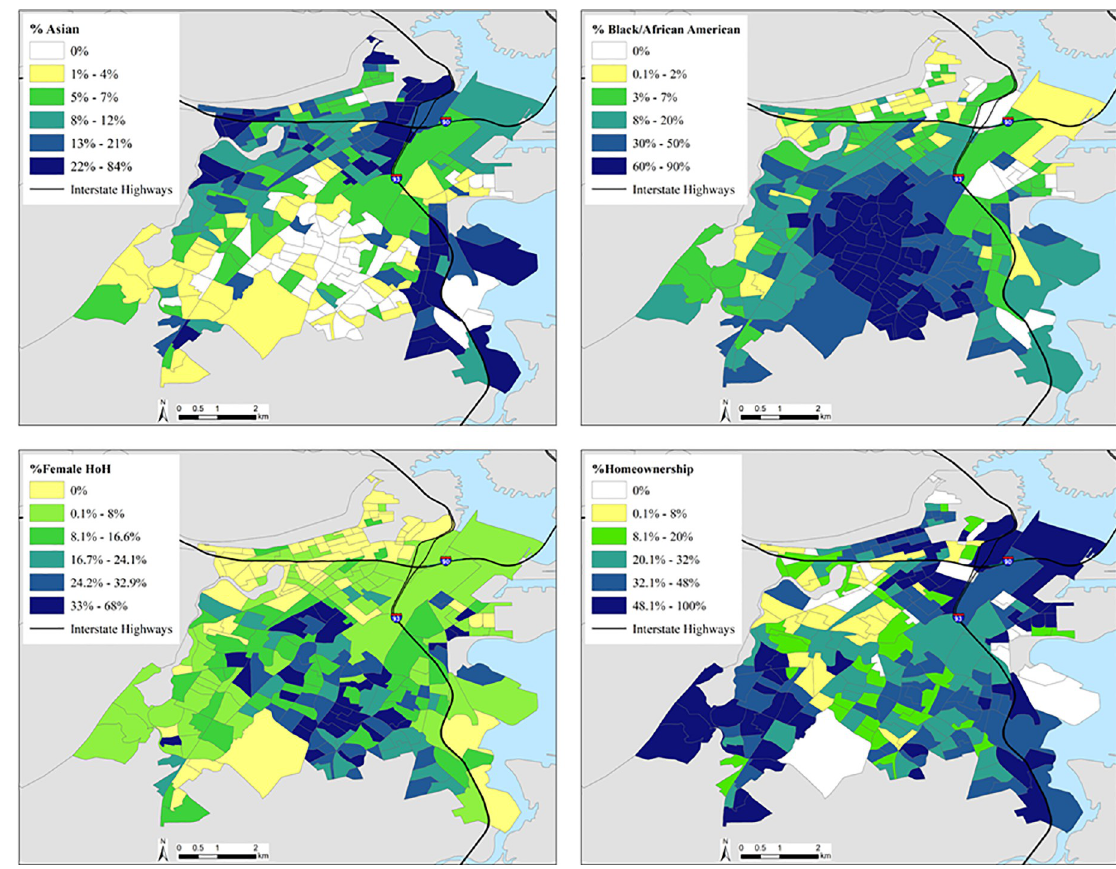
Fig 2. Map of block group level concentrations of variables in the stepwise linear regression model divided into quintiles.